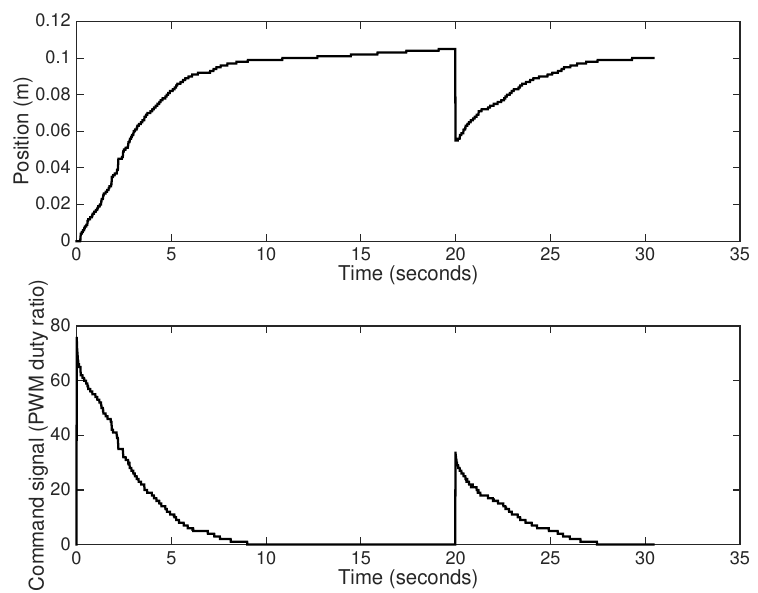
Figure 7. Fractional order PD controller experimental validation in the non-Newtonian environment. Experimental robustness tests have been performed by replacing the non-Newtonian liquid inside the cardiovascular setup with tap water. The same desired input is given to the submersible in the two operating environments, Newtonian and non-Newtonian, and the position profile for both cases is presented in Figure 8. It can be observed that the settling time for the Non-Newtonian case is 5 s faster than the tap water experiment. However, the controller proves to be robust to high environmental variations, such as the nature of the fluid, proving robustness to more than just the process’s proportional gain changes.